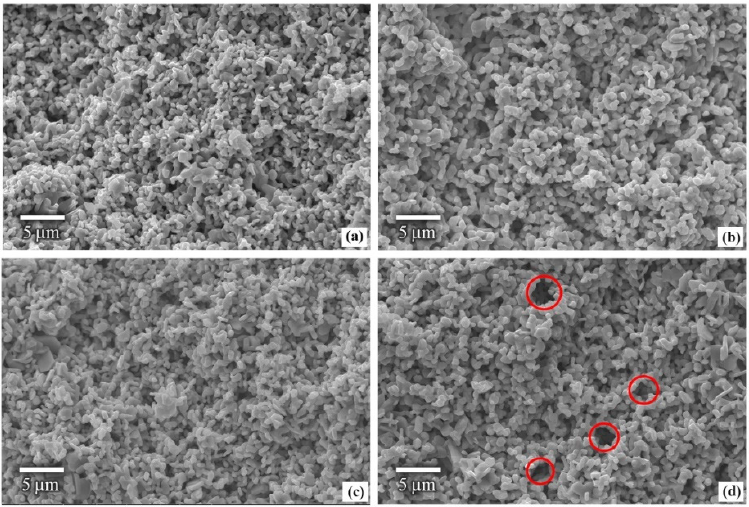
Figure 2. SEM micrographs of samples ( a ) S20, ( b ) S23, ( c ) S26, and ( d ) S29 with circles highlighting the voids. the